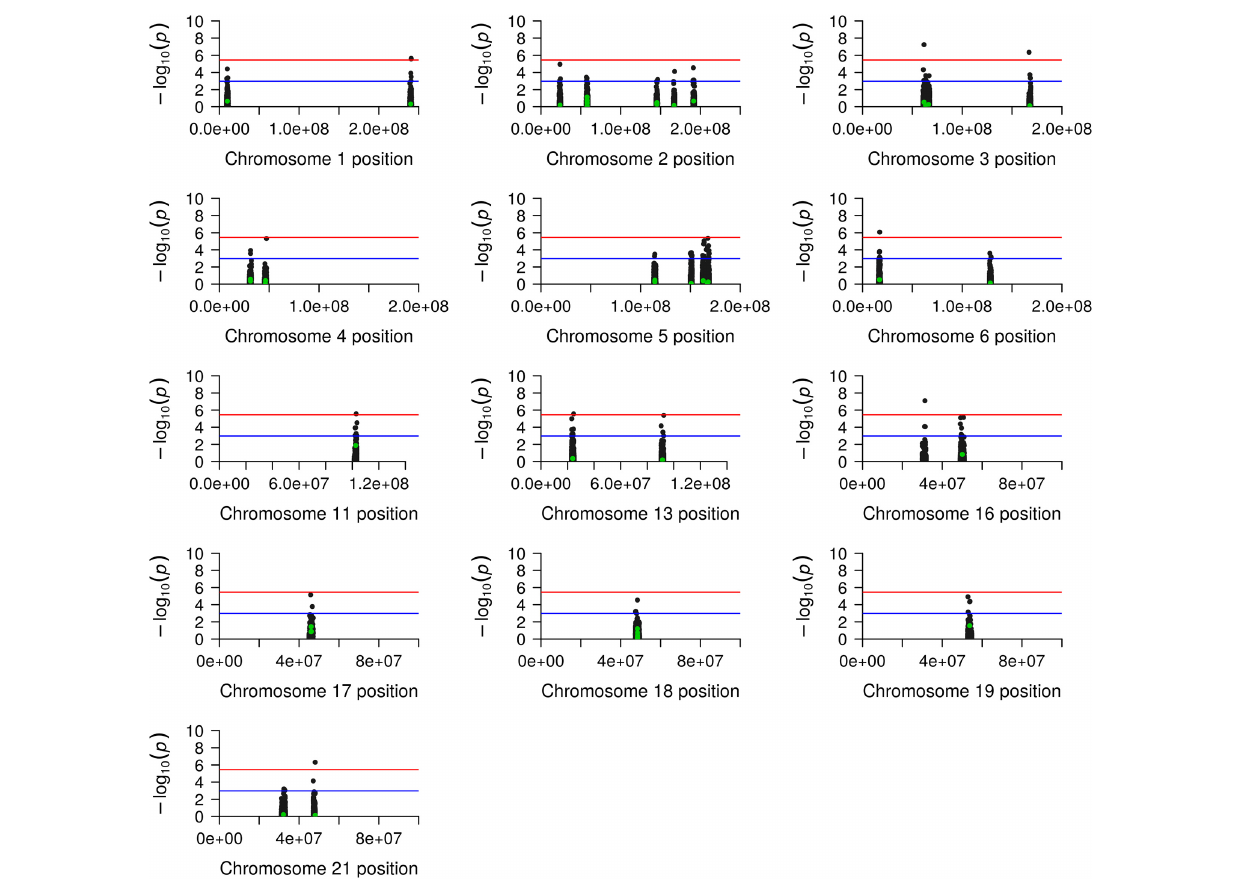
FIGURE 3 | Manhattan plot of genetic generalized epilepsy (GGE) candidate regions. The figure shows a plot for each candidate chromosome, including the chromosome position ( x -axis) and the –log10( p- value) in the y -axis. The green and black points represent the candidate and the flanking single-nucleotide polymorphisms (SNPs), respectively. The blue line indicates the suggestive association signal based on the p -value adjusted by the Bonferroni correction under the 48 candidate SNPs. The red line indicates the association signal based on the p- value adjusted by Bonferroni under the 48 candidate SNPs plus the 14,047 flanking